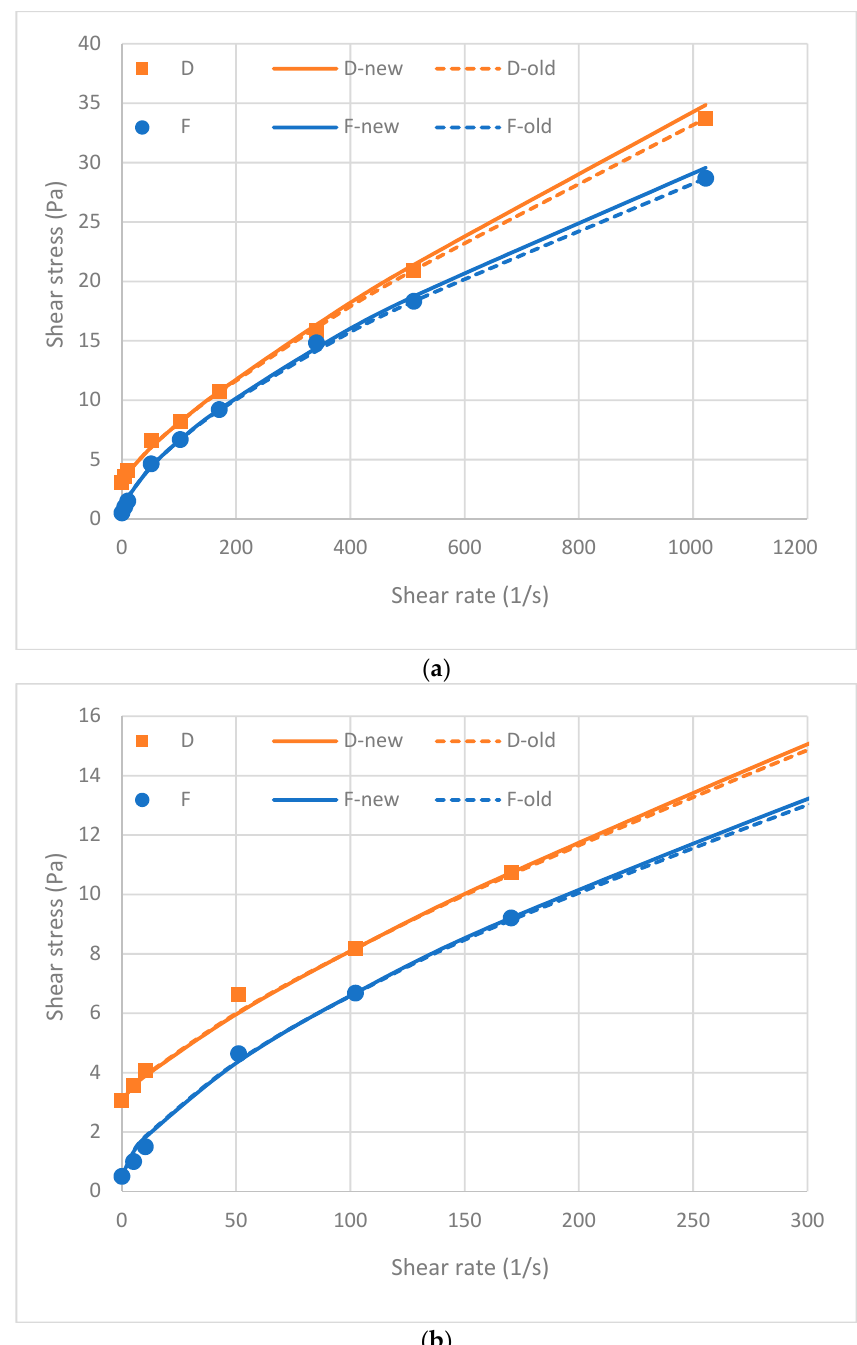
Figure 5. Flow curves of drilling fluids D and F. ( a ) Upper figure—Full shear rate range; ( b ) Lower figure—Relevant shear rates.